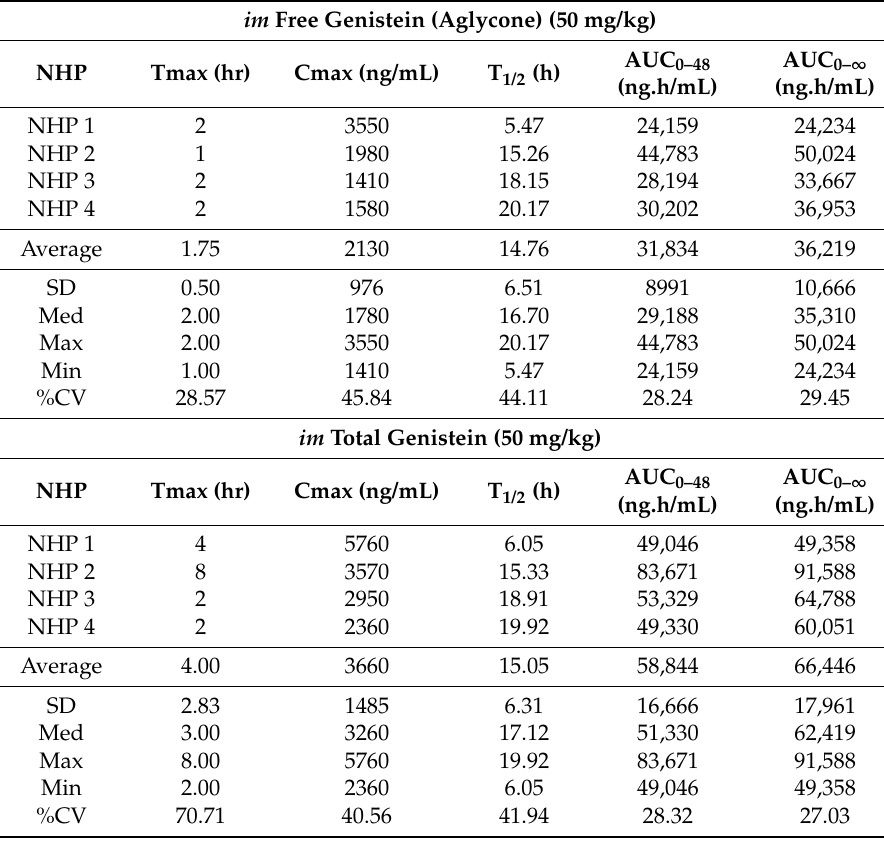
Table 1. PK im study sample analysis of free and total